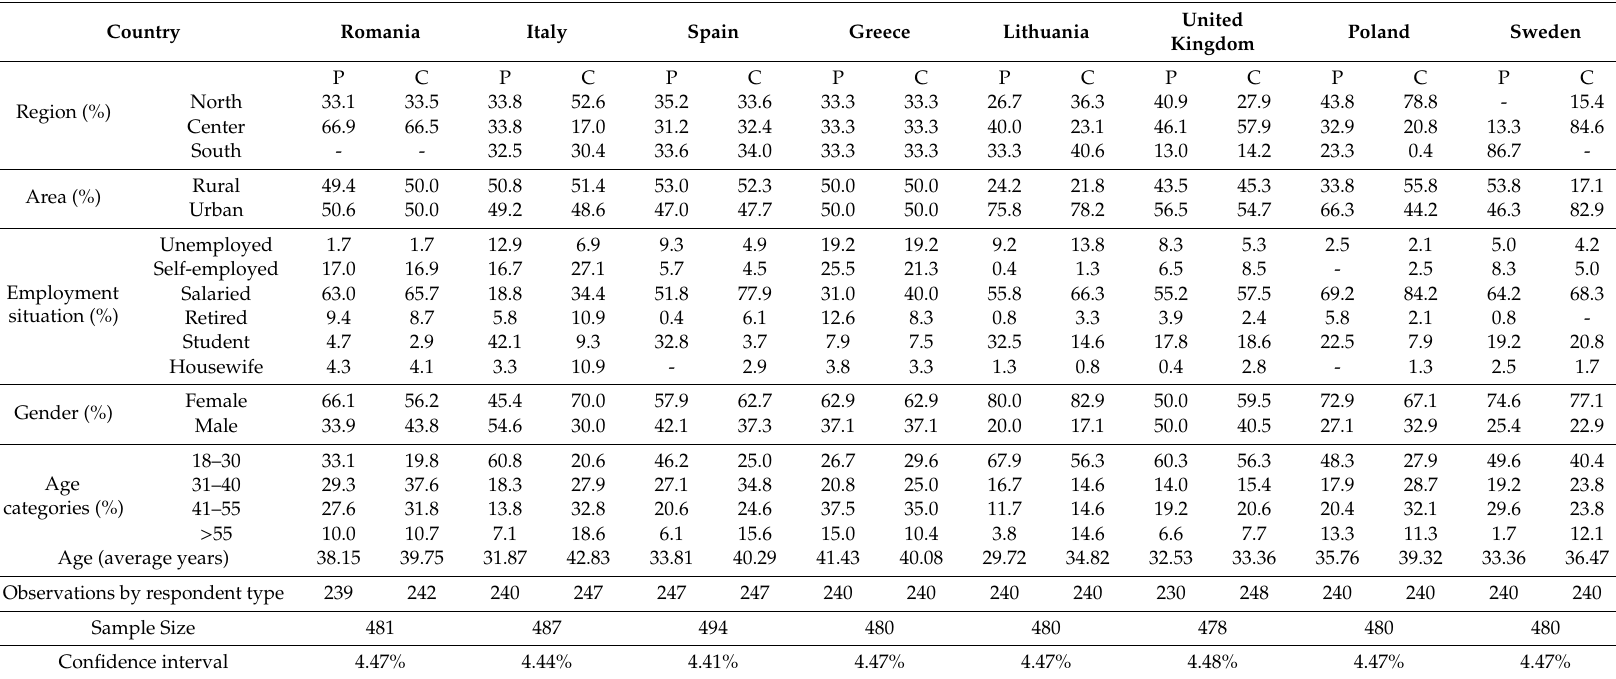
Table 1. Summary of socio-demographic variables of the samples by groups and country (values are in